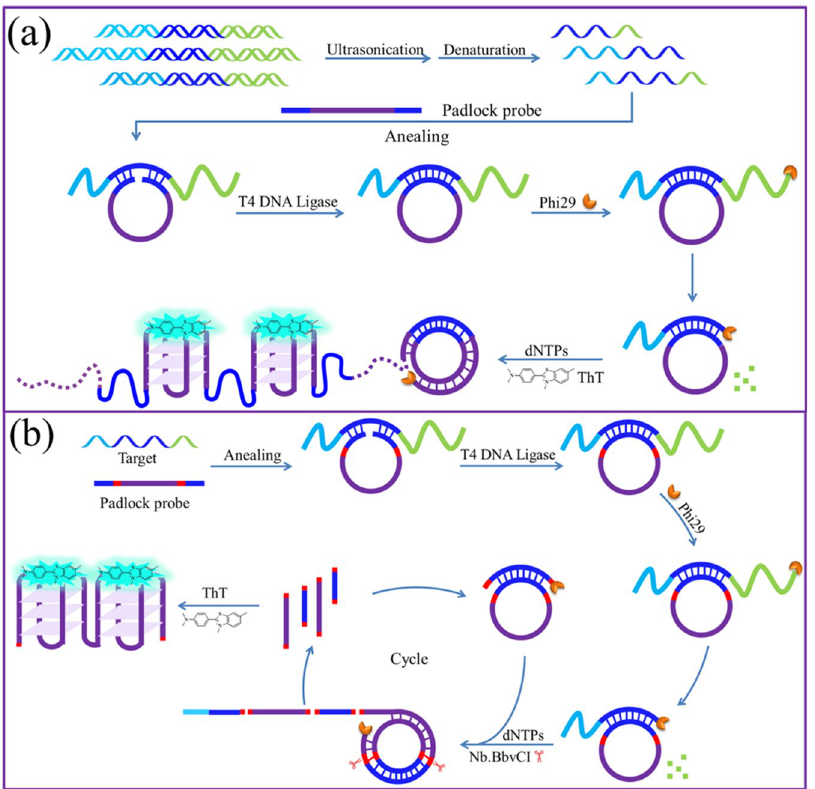
Figure 1. Working mechanism of ED-RCA for detection of target DNA embedded long-stranded genome. ( a ) Linear RCA mode; ( b ) Exponential RCA